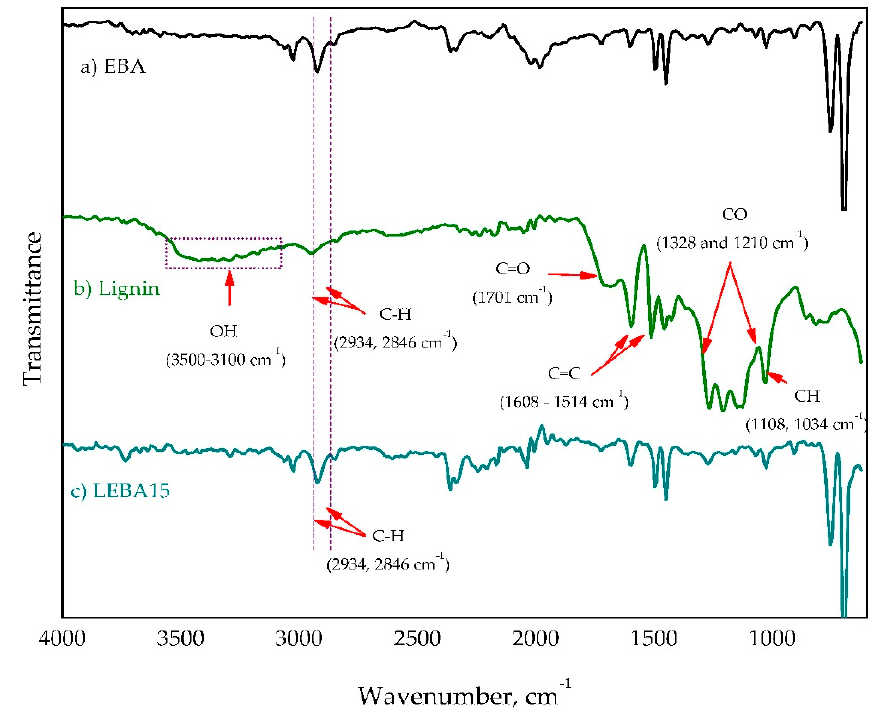
Figure 2. Infrared spectra of ( a ) EBA, ( b ) Lignin, and ( c ) LEBA15.